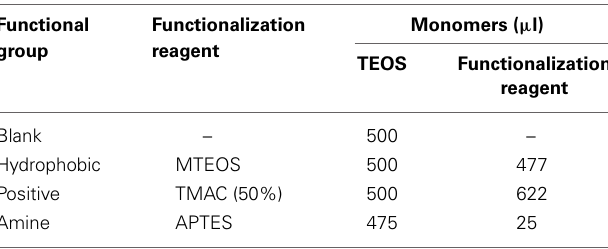
Table 3 | Quantities of reagents required to make blank, amine functionalized, hydrophobic and positively charged sol-gel